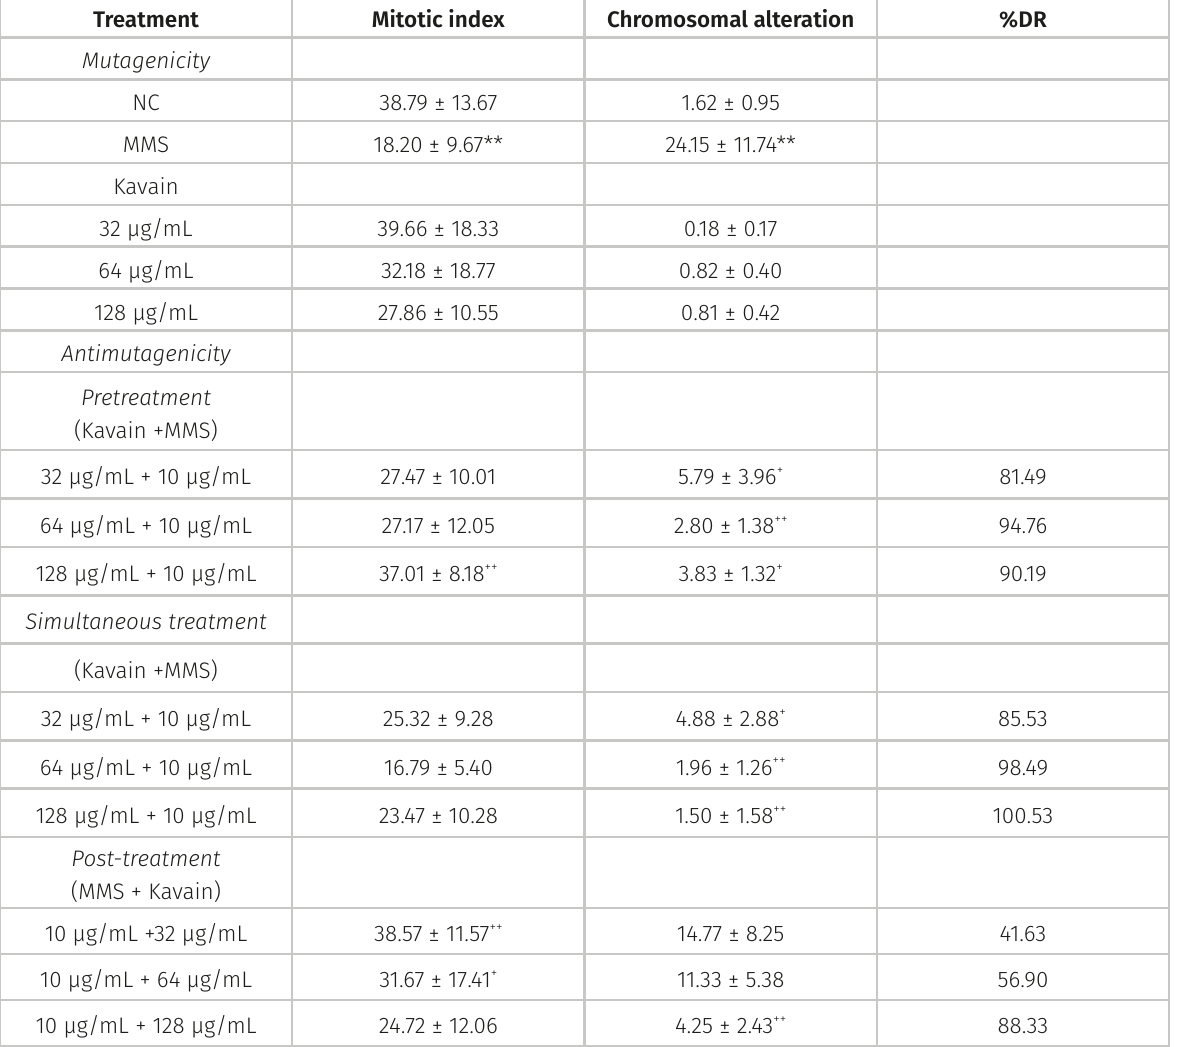
Table I. Mitotic index, total chromosomal alterations and percentage of damage reduction (%DR) in meristematic cells of A. cepa